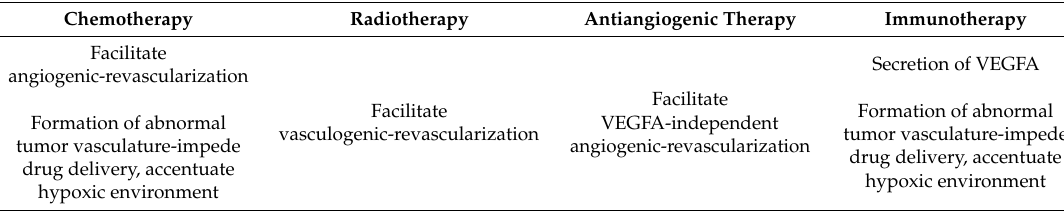
Table 2. Myeloid cell contributions to cancer therapy